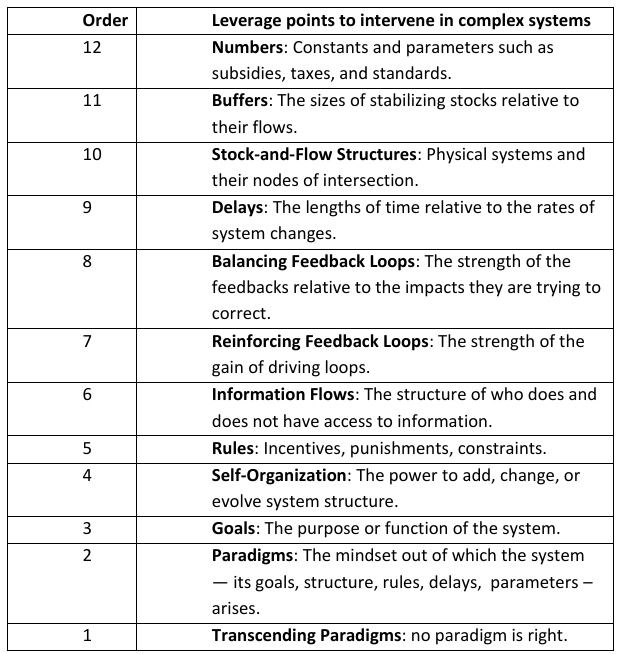
Table 1: A list of leverage points to intervene in complex systems in increasing order of effectiveness (modified from Meadows